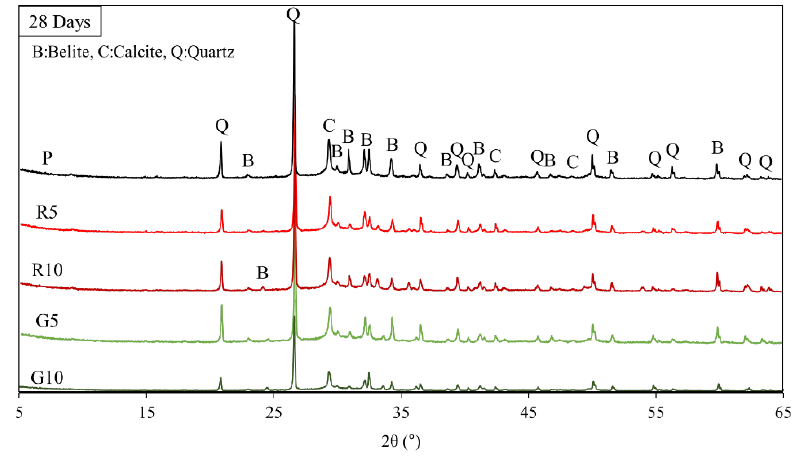
Figure 6. XRD patterns of samples showing the specimen powders produced at 28 days of age, where peaks B, C, and Q represent belite, calcite, and quartz,